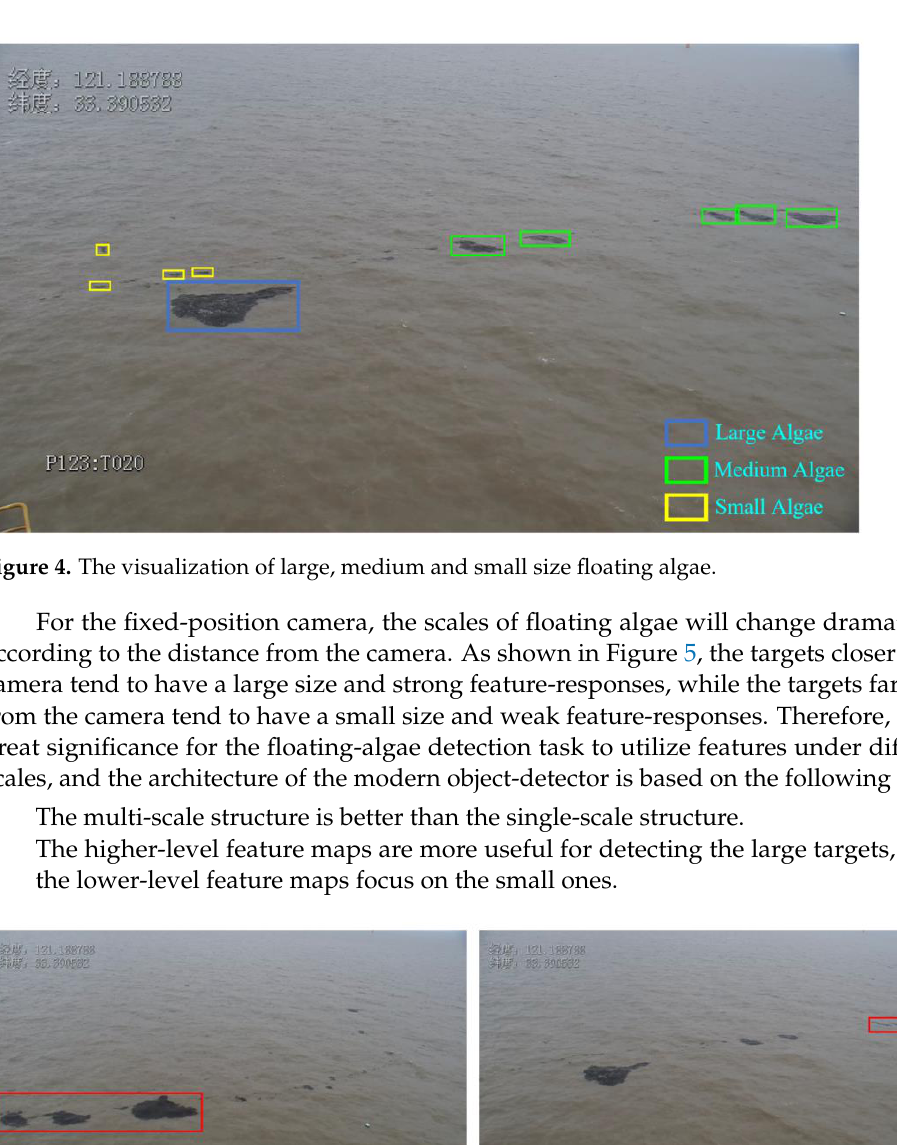
Figure 6. The architecture of FPN, BiFPN and Ms-BiFPN. ∝ 1 , ∝ 2 and ∝ 3 represent the coefficients of adaptive pooling, and the values are 0.1, 0.2 and 0.3, respectively, in this paper. N represents the number of scale factors used in adaptive pooling, and the value is 3.